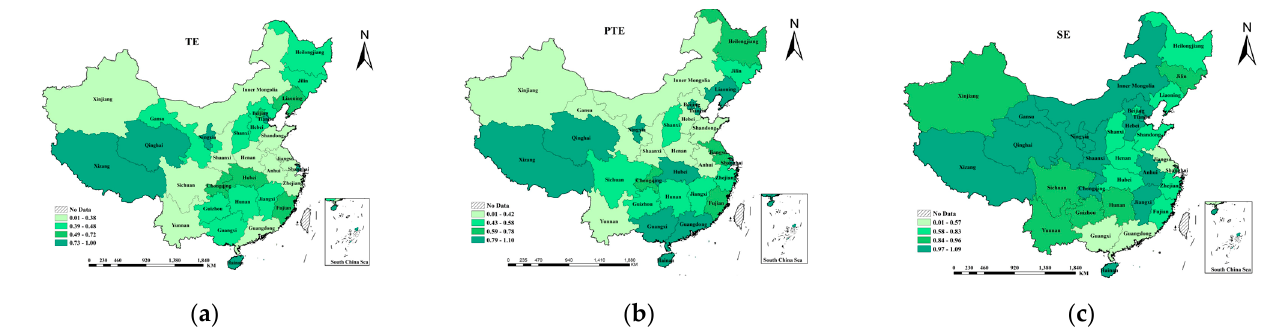
Figure 1. The first-stage technical efficiency and scale efficiency of provincial public sports service: ( a ) the technical efficiency of each province; ( b ) the pure technical efficiency of each province; ( c ) the scale efficiency of each province.